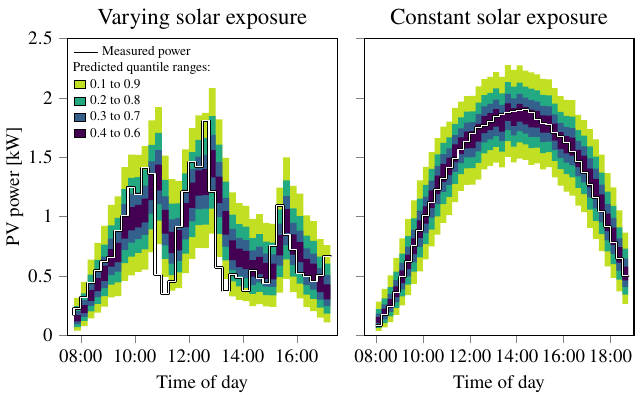
Figure 3. Probabilistic forecast of the MDN for a day with varying and constant solar exposure. For better illustration, the estimated probability distributions of the mixture distributions are con- verted into intervals, and only the next step ahead forecast (forecast horizon corresponds to 15 min) is shown. The width of the intervals depends on both the level and the volatility of the PV power.